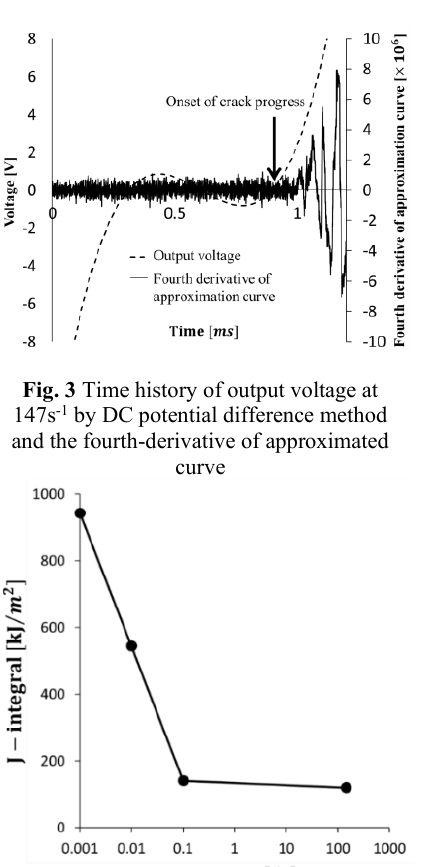
Fig. 4 Nominal stress-strain curve at various strain